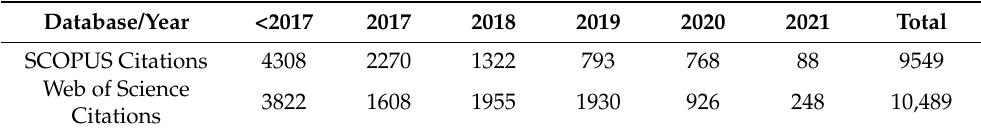
Table 1. Comparative yearly citation analysis.